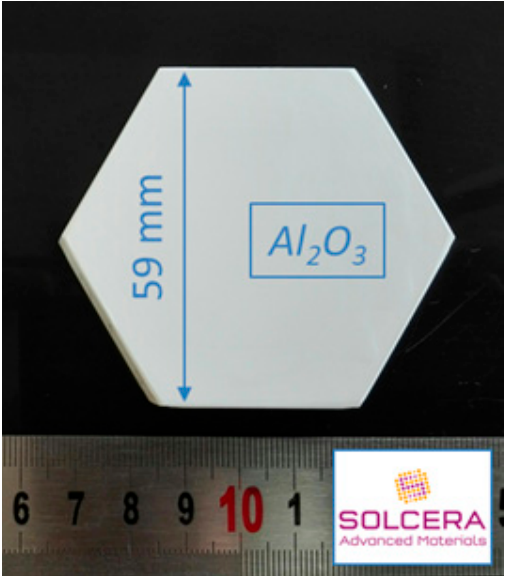
Figure 2. Picture showing a green sample of hexagonal-shaped alumina material. Samples were shaped by slip casting by SOLCERA Advanced Materials company.